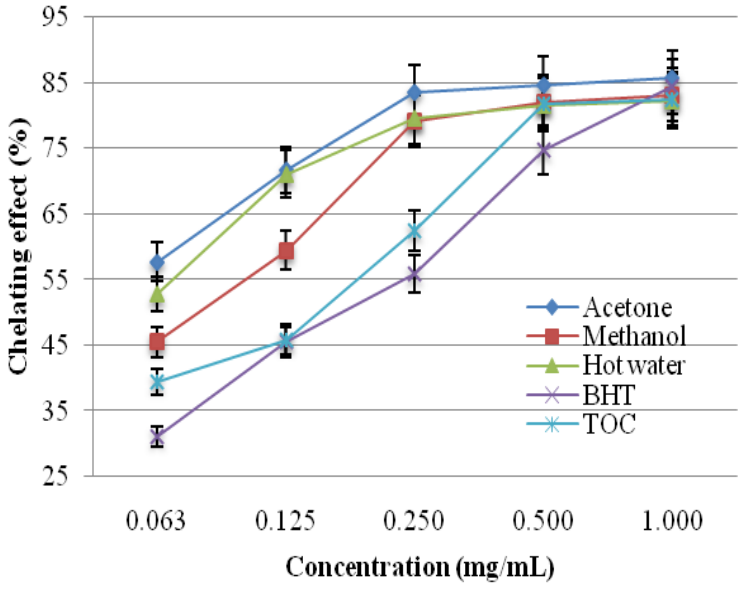
Figure 2. Chelating effect of various extracts from the fruiting bodies of Pleurotus florida . Values expressed as means ± SD ( n = 3). BHT, butylated hydroxytoluene; TOC, α